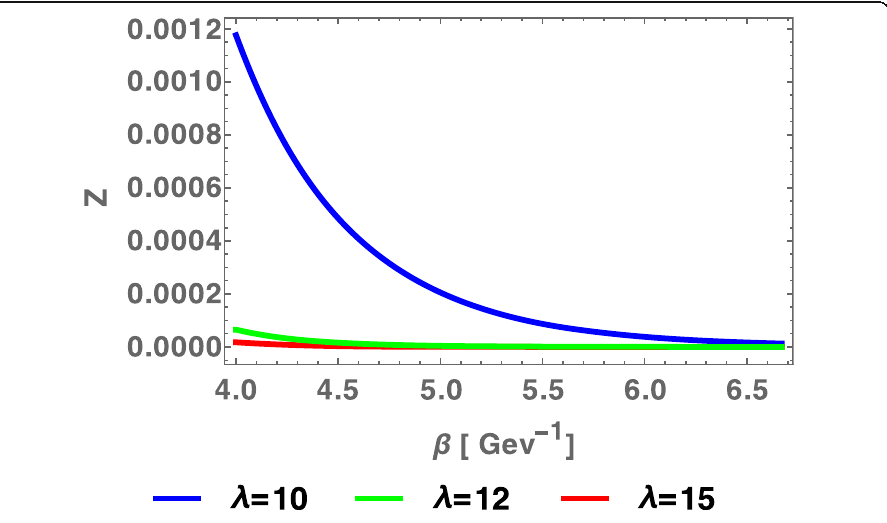
Fig. 1 Partition function is plotted as a function of β for different values of